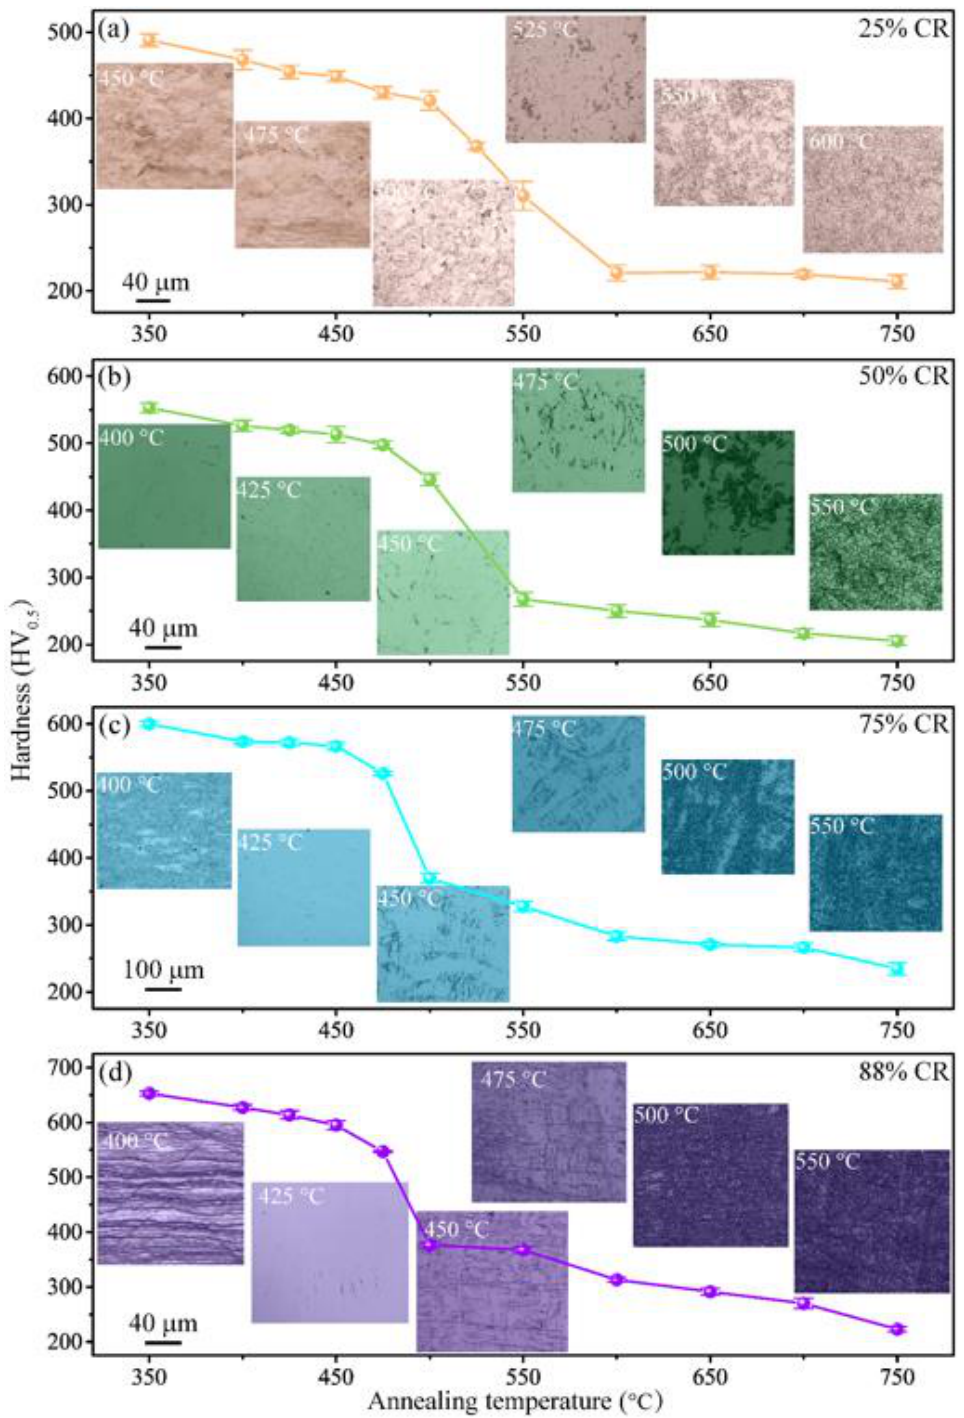
Figure 5. The relationship among annealing temperatures, hardness, and microstructural evolution of Fe – 19Mn – 0.6C TWIP steel at ( a ) 25%, ( b ) 50%, ( c ) 75%, and ( d ) 88% CR deformation. As the annealing temperature increased to 425 ◦ C, recrystallized refinement grains appeared at the grain boundaries and hardness dropped. With the increase of annealing temperature, the fraction of recrystallization grains gradually increased while hardness quickly decreased. This result may have been caused by the high-density dislocations and the newly formed tiny grains offsetting the strain-hardening effect during recrystallization. Hence, it can be deduced that the RST ranged from 400 to 425 ◦ C at 50% CR deformation